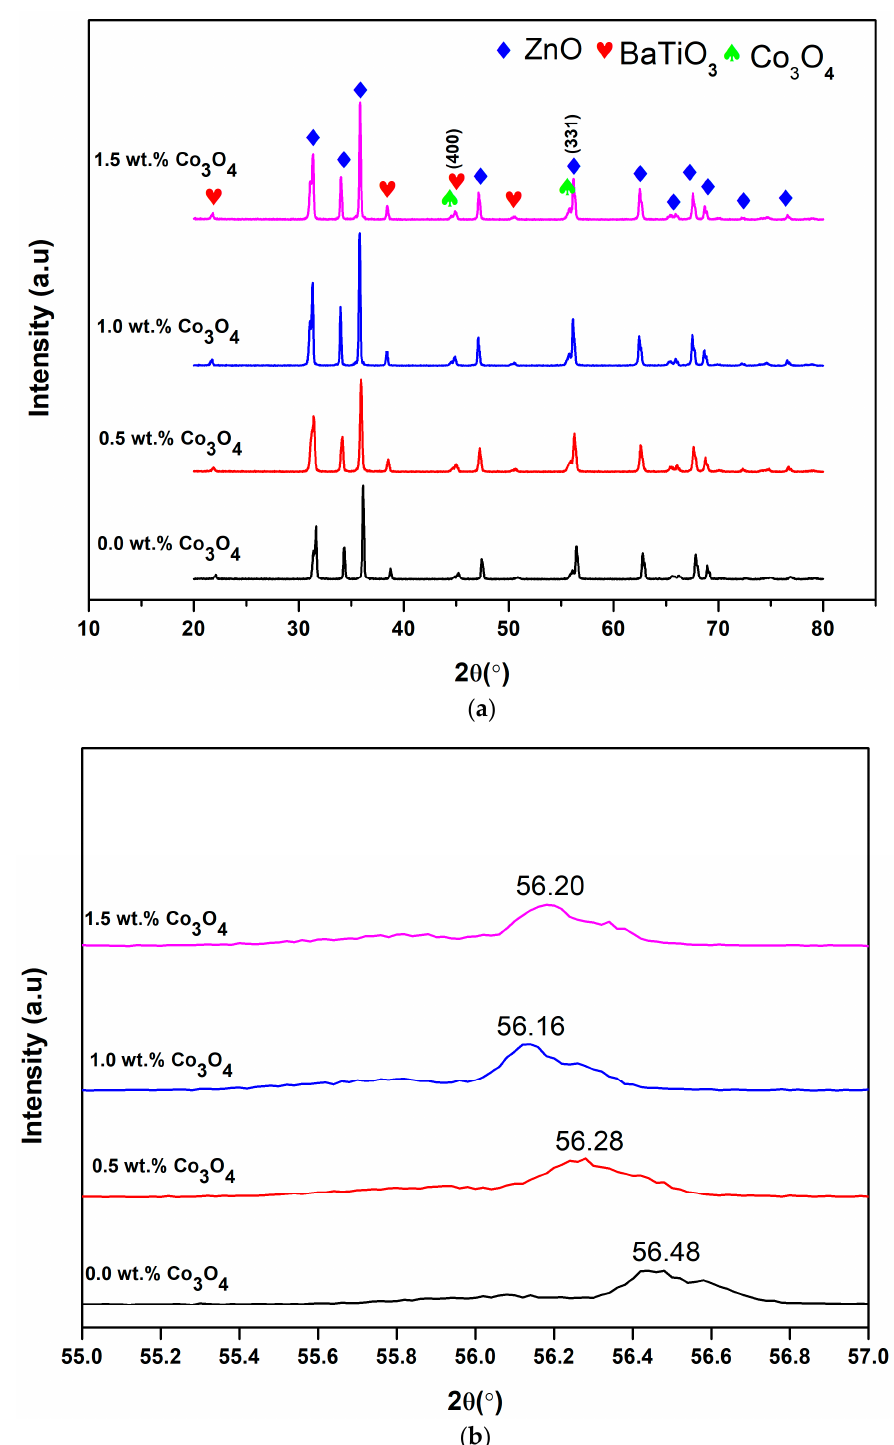
Figure 2. The XRD spectra of ZnO-BaTiO 3 based varistor doped with different amounts of Pr 6 O 11 ( a ) XRD patterns of Pr 6 O 11 -doped ZnO-BaTiO 3 varistor ceramics and ( b ) XRD patterns of (220) diffraction.